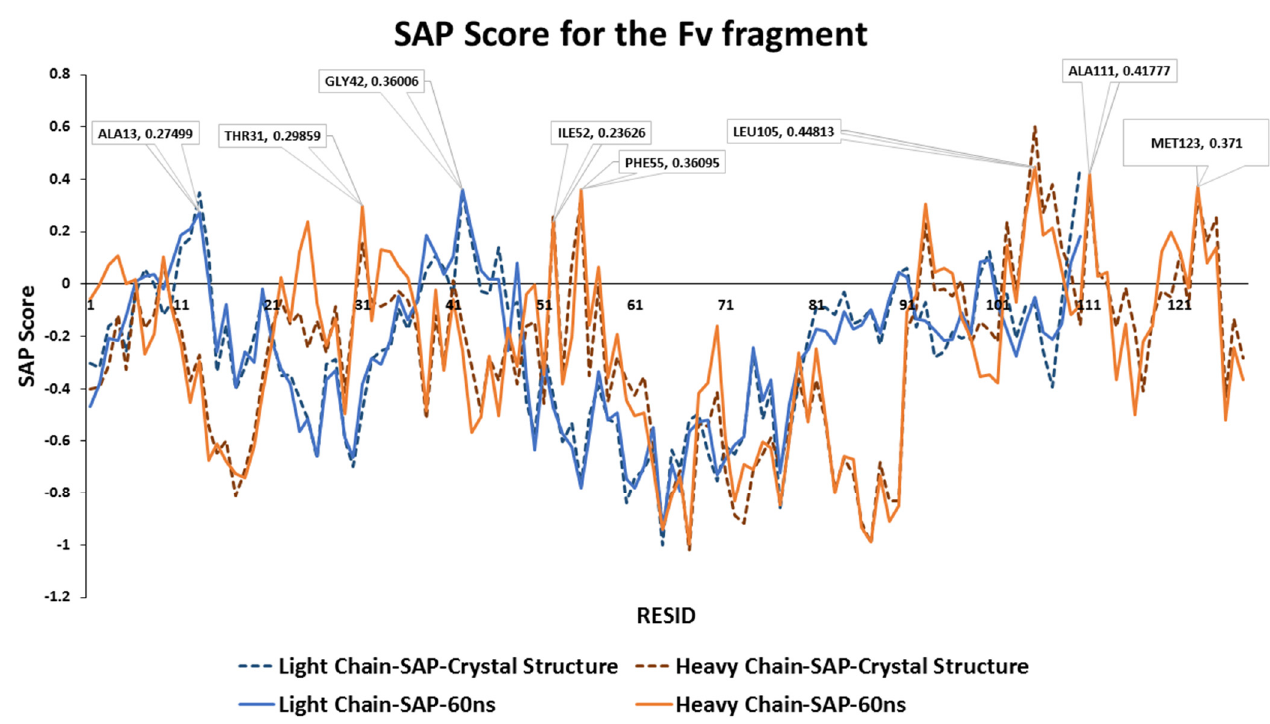
Figure 2. Residue-average SAP scores calculated at R = 10 Å for mAb1 Fv fragment crystal structure and the final snapshot after a 60 ns MD simulation. Residues with SAP scores calculated from the structure at 60 ns greater than 0.15 were highlighted. The SAP scores of individual residues are similar in the crystal structure and the snapshot of the MD simulation at 60 ns. LEU105 on the heavy chain has the highest calculated SAP score within the Fv fragment.